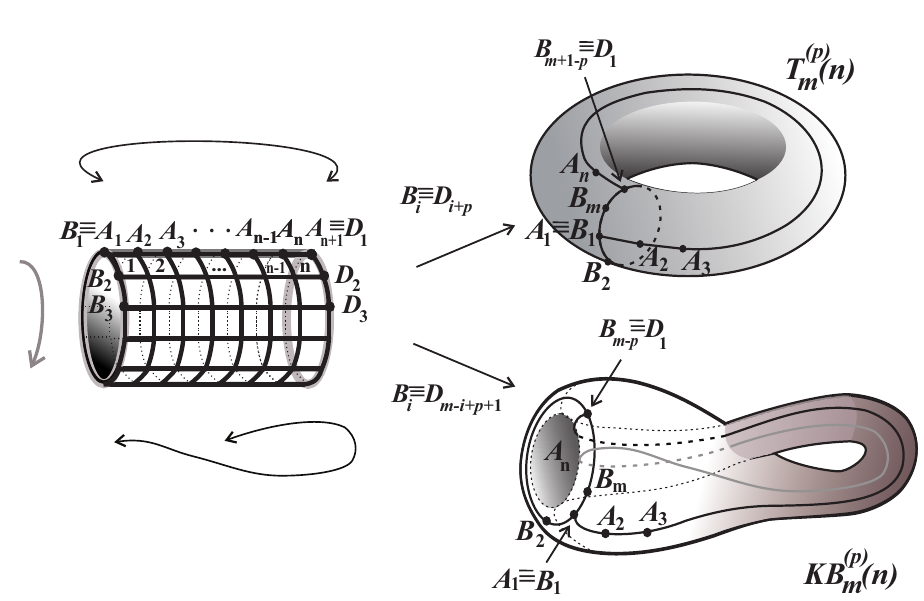
( p ) ( n ) = C m × C n and Klein bottle KB ( p ) m